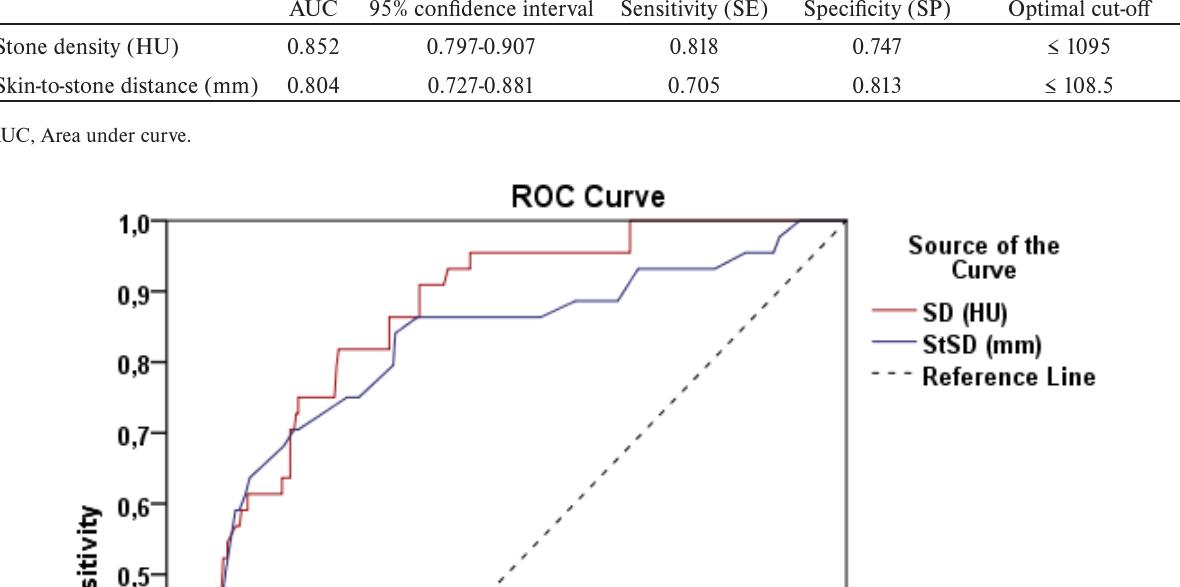
Table 5. Statistical evaluation of CT parameters of stone density and skin-to-stone distance. AUC Optimal cut-off Stone density (HU)